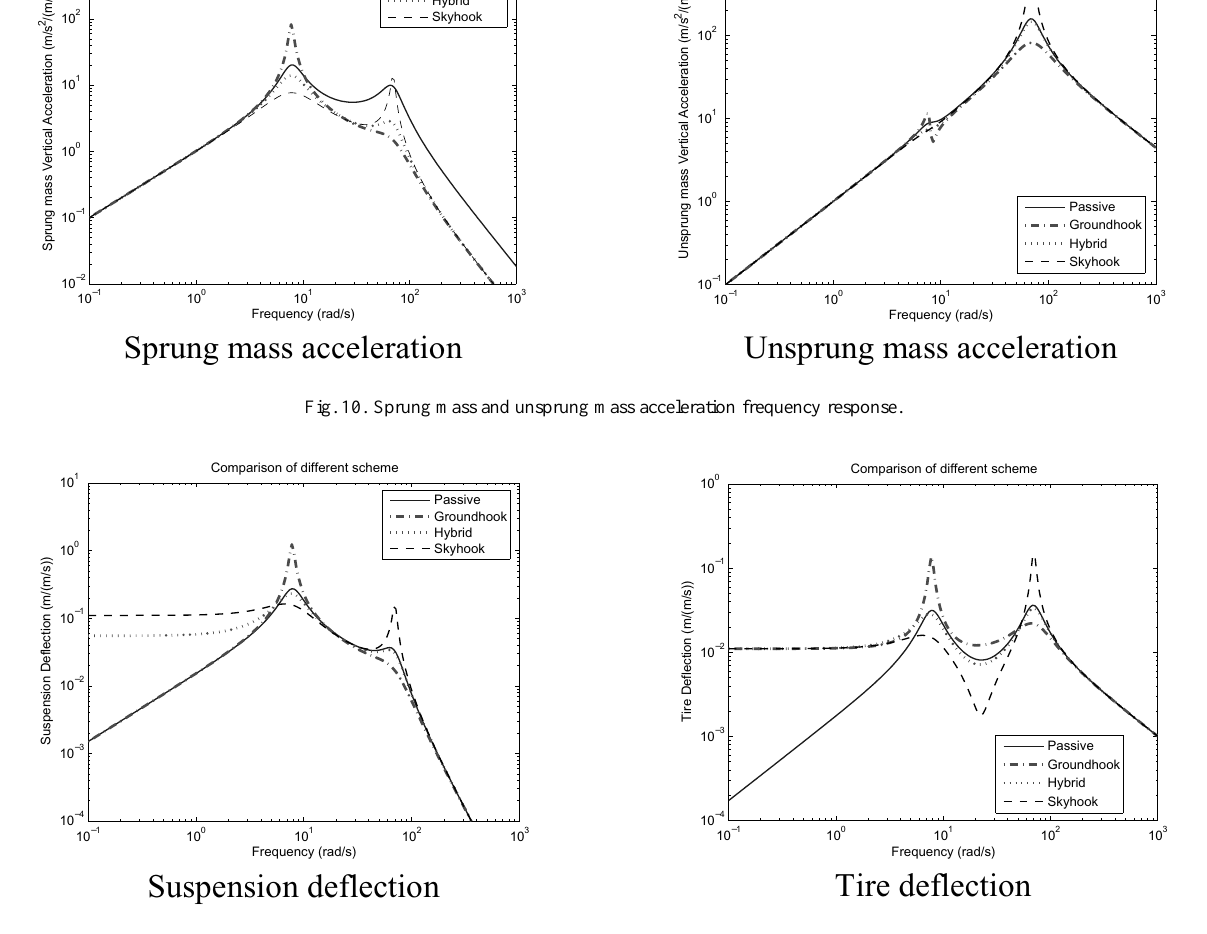
Fig. 11. Suspension and tire deflection frequency